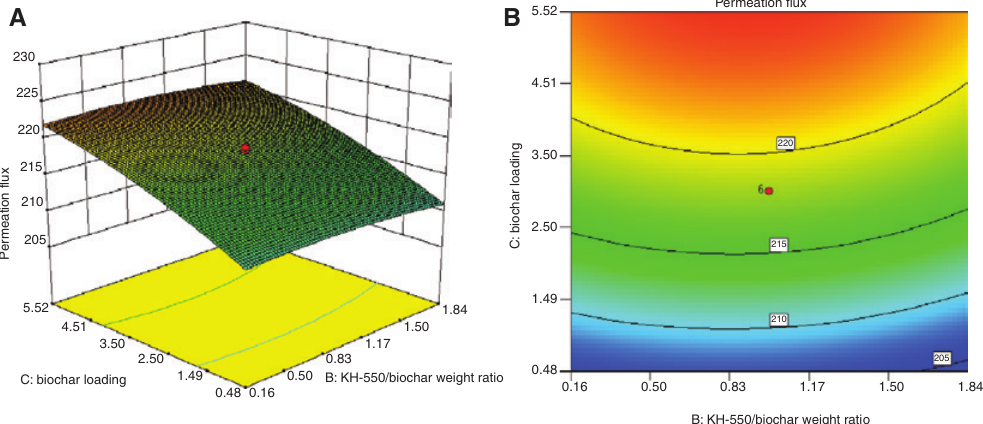
Figure 8: 3D surface plot (A) and contour plot (B) exhibiting the influences of the crosslinker/BB weight ratio and the BB loading amount on the permeation